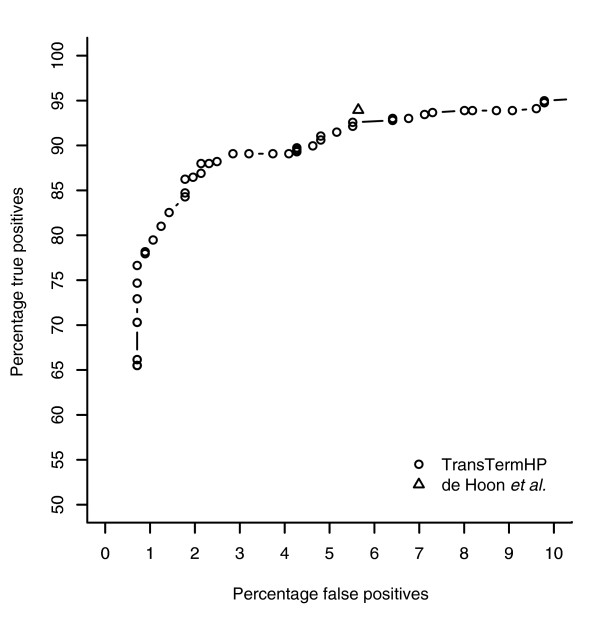
Performance of TransTermHP in B. subtilis. Receiver operator characteristic (ROC) curve showing the percentage of positive regions for which TransTermHP finds a terminator for various low false positive rates (circles), using a data set derived from experimentally verified operons [3]. The reported performance of the method described by de Hoon et al. [3] on this set after training is also shown (triangle). TransTermHP performs comparably without fitting parameters to the data set.